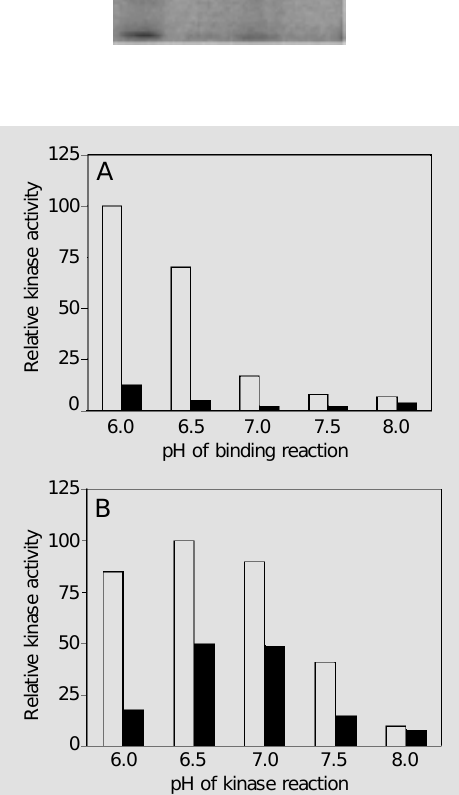
Figure 2 - Comparison of in vitro phosphorylation of Cx43 and Cx46. GST (glutathione-S-trans- ferase) fusion proteins derived from Cx43 or Cx46 were pre- pared and analyzed for phospho- rylation by sheep heart extracts. The pH of both the binding and kinase reactions was the same and is indicated in the figure. The results indicate that the ki- nase reaction was enhanced against Cx43 at lower pH.